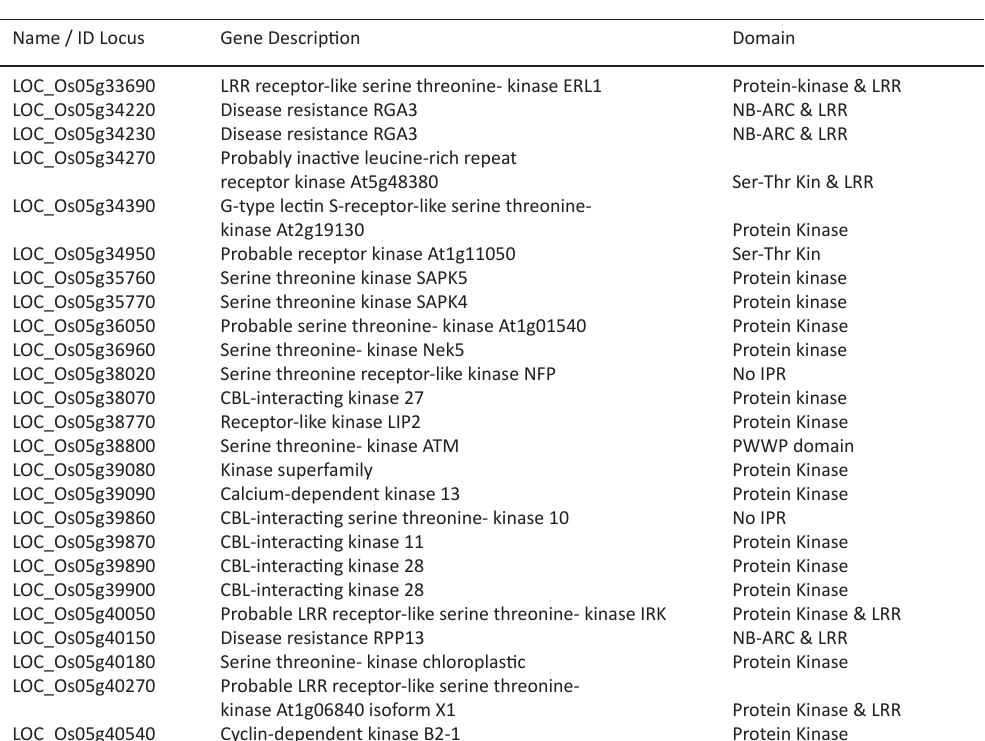
Table 2. List of disease resistance genes in qLBL5 Name / ID